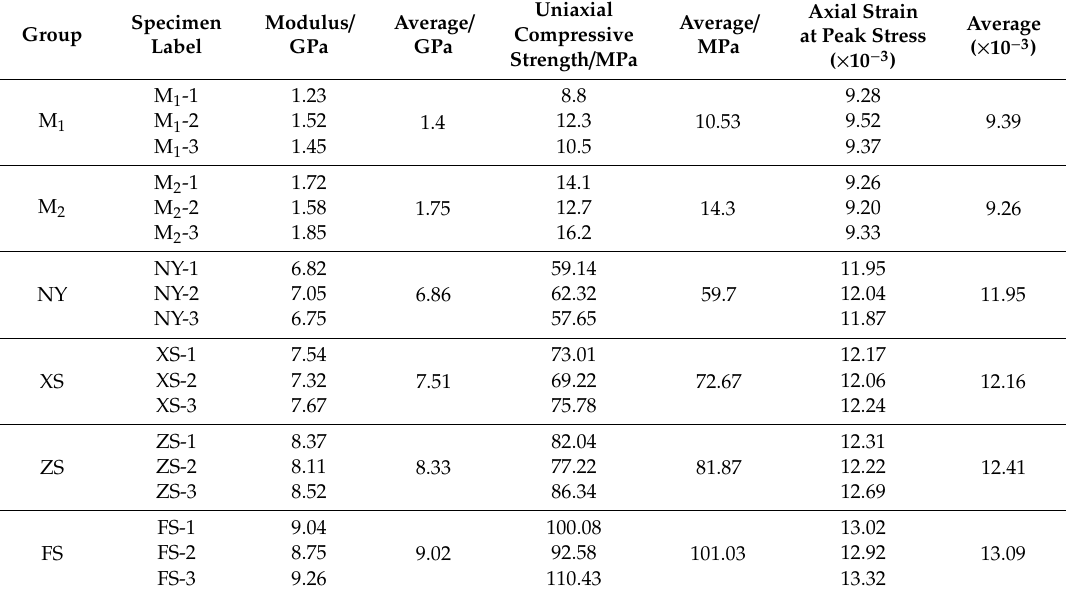
Figure 6. The axial strain at the peak stress of the CRC specimens. Table 2. Young’s modulus, uniaxial compressive strength and axial strain at peak stress of the pure coal / rock